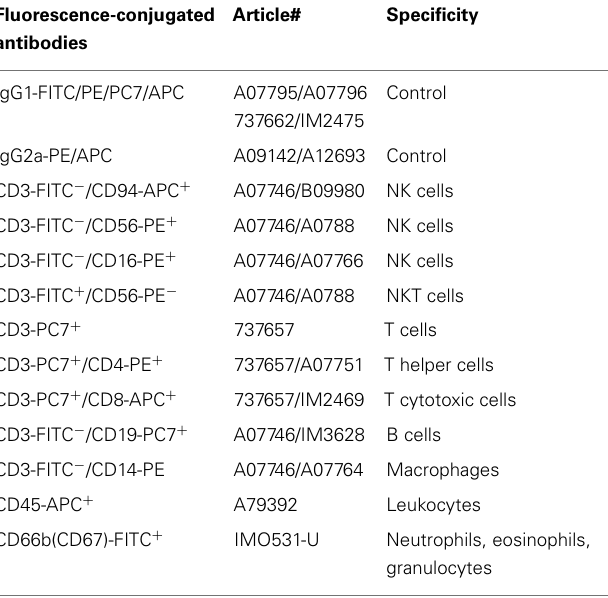
Table 2 | Panel of CE-certified, fluorescence-labeled antibodies (Beckman Coulter), which are used in the clinical trial